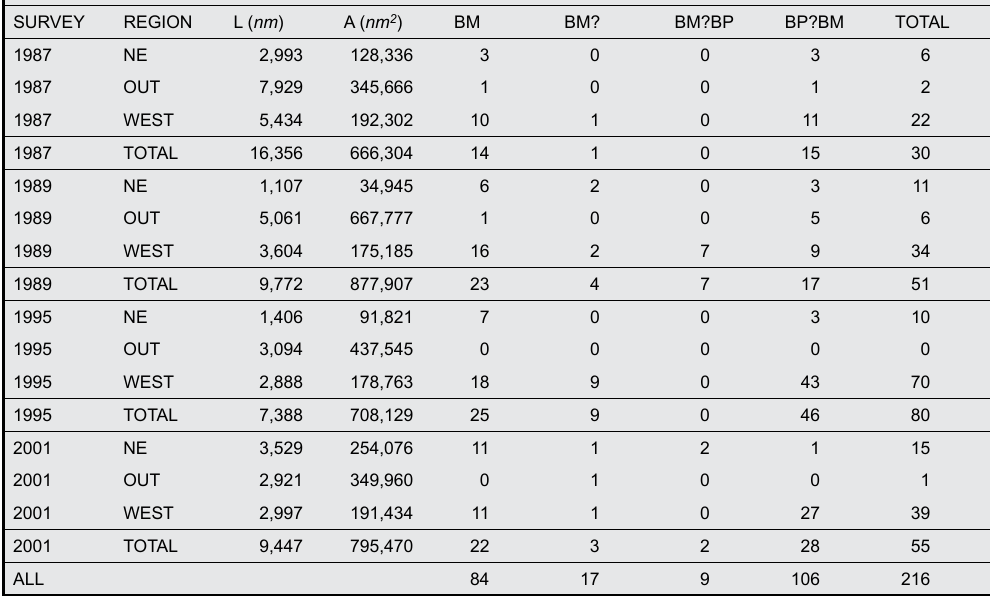
Table 1. Numbers of sightings by region for NASS, 1987-2001. L – effort; A – area.